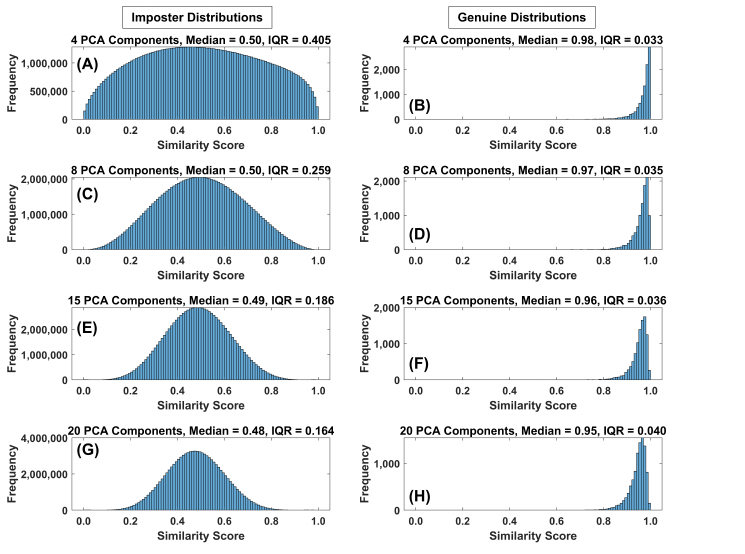
Figure 14. ( A ) Histogram of the impostor similarity score distribution for FaceNet PCA components (4 PCA components, 10,000 subjects (all histograms)). Note the median and IQR value just above the histogram. ( B ) Histogram of the genuine similarity score distribution for 4 PCA components. ( C ) Histogram of the impostor similarity score distribution for 8 PCA components. ( D ) Histogram of the genuine similarity score distribution for 8 PCA components. ( E ) Histogram of the impostor similarity score distribution for 15 PCA components. ( F ) Histogram of the genuine similarity score distribution for 15 PCA components. ( G ) Histogram of the impostor similarity score distribution for 20 PCA components. ( H ) Histogram of the genuine similarity score distribution for 20 PCA